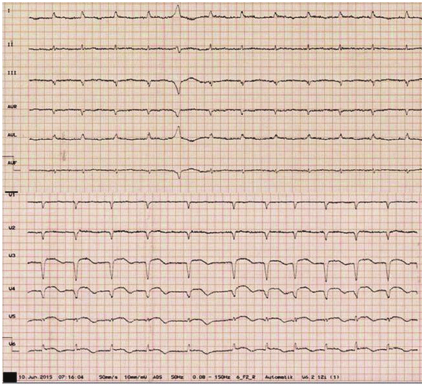
Figure 1: Initial twelve-lead ECG demonstrating atrial fibrillation and ST-segment elevation of the anterior leads.